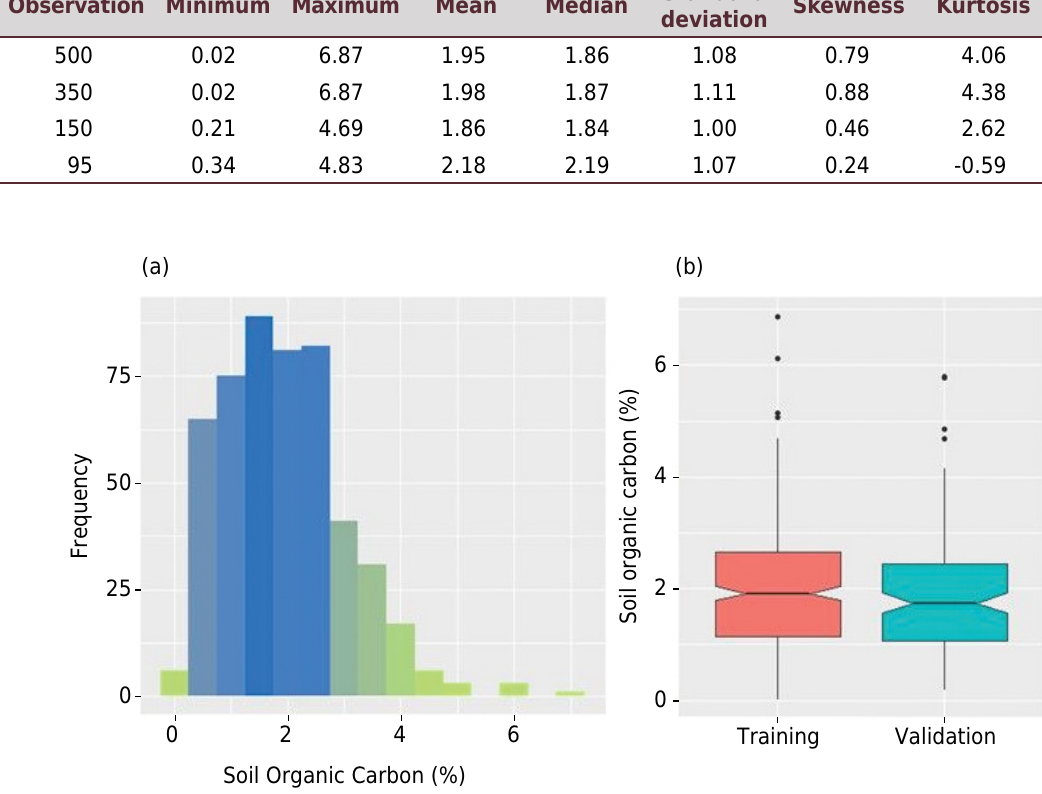
Table 3. Descriptive statistics of SOC for whole, training and validation sets Set Observation Minimum Maximum